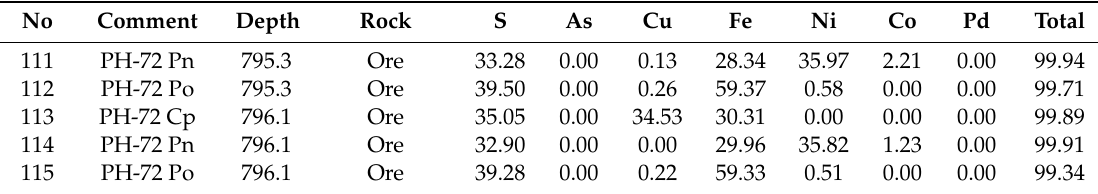
Figure 7. Microparageneses of the minerals in the olivine gabbro-dolerite: ( a , b ) pyrrhotite- pentlandite-chalcopyrite aggregates; ( c ) chalcopyrite grain in intergrowth with magnetite (Mt). Contact gabbro-dolerite is found in most boreholes at the contact of the intrusion with the host rocks in the form of layers 0.3–5-m thick; the greatest thickness of these rocks (up to 10 m) has been identified in boreholes PH-222 and PH-72. Low contents of ore elements (about 5 ppm in PH-72 and PH-133 and less than 1 ppm of PGEs in other boreholes) are observed in contact gabbro-dolerites. These horizons are characterized by schliere-disseminated sulfide mineralizations of pyrrhotite,